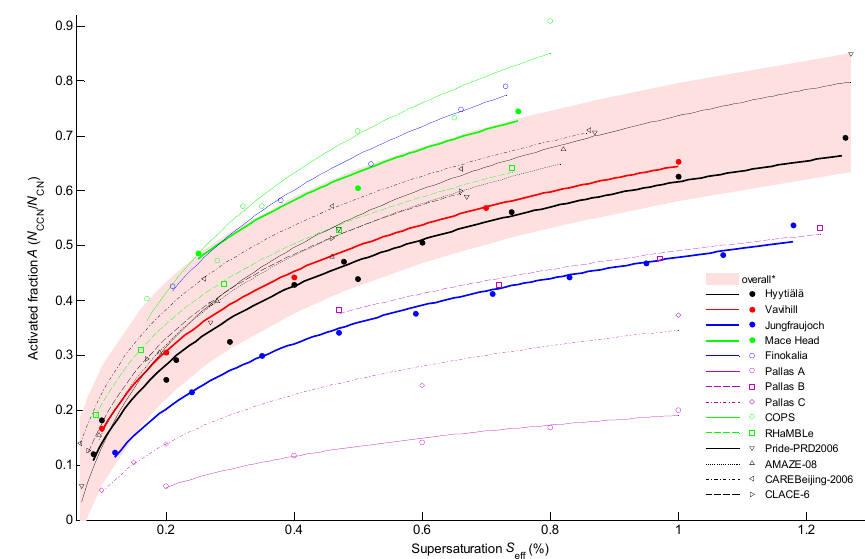
Figure 4. Average activated fraction A as a function of supersaturation S eff for all available data sets. Symbols represent arithmetic mean values of A calculated from all available data for each station for each S eff level. Lines represent the linear fits in the form A = a × ln (S eff ) + b . Also shown is the overall fit based on most of the data points (*Finokalia, COPS, Jungfraujoch and Pallas A, B and C data sets excluded). The shading of the overall fit represents the prediction bounds of the fit with a confidence level of 95%. Slope, intercept and correlation coefficient values of the linear fits can be found in Table